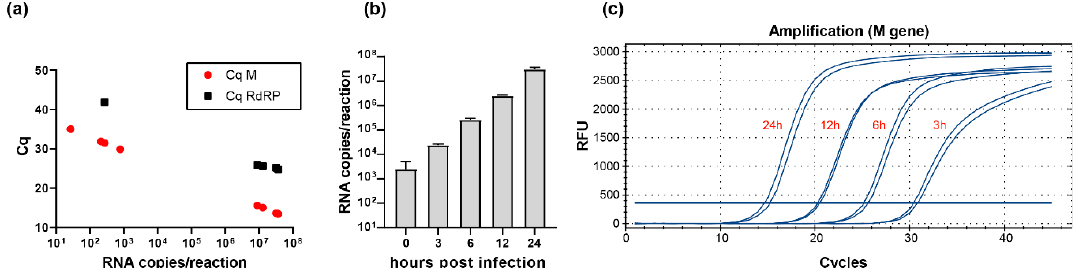
Figure 4. Detection of intracellular SARS-CoV-2 RNAs. ( a ) Vero cells were infected with SARS-CoV-2 isolate FFM1 (MT358638) with high and low MOI, and 24 h post infection, the RNA was subjected to M- and RdRP-gene-specific one-step probe qRT-PCR analysis (Luna, NEB). Intracellular copy numbers ( b ) and representative amplification curves ( c ) of SARS-CoV-2 isolate FFM1-infected Caco-2 cells determined with the M-gene primer pairs and probe. Total cellular RNA including viral RNA was harvested at the indicated time points and subjected to M-gene specific qRT-PCR analysis.